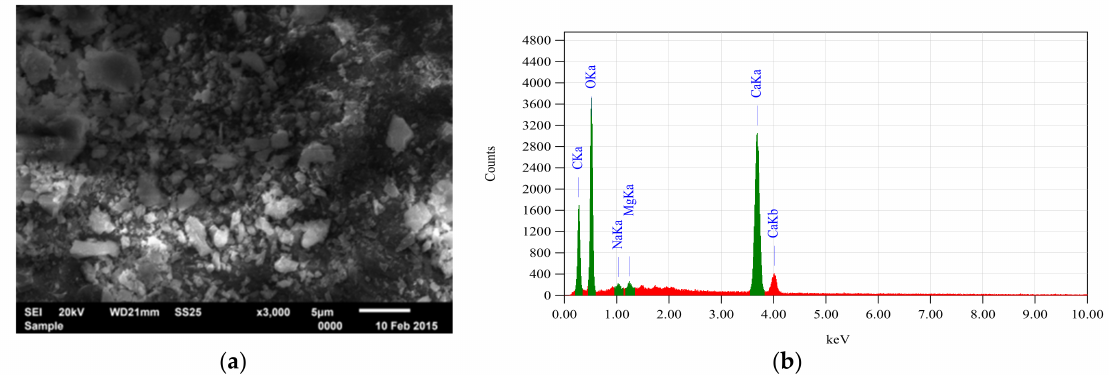
Figure 11. ( a ) 3000x magnification of Scanning Electron Microscope of Perna viridis Linn flour ( b ) EDX oxide of Perna viridis Linn.